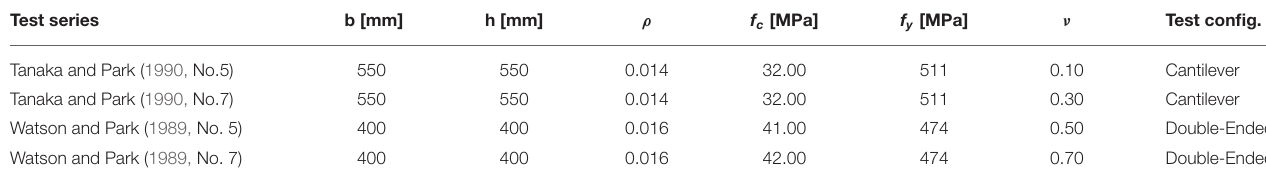
TABLE 1 | Four experimental tests extracted from the Pacific Earthquake Engineering Research Centers Structural Performance Database (Berry et al., 2004). Test series b [mm] h [mm] ρ f c [MPa] f y [MPa] ν Test